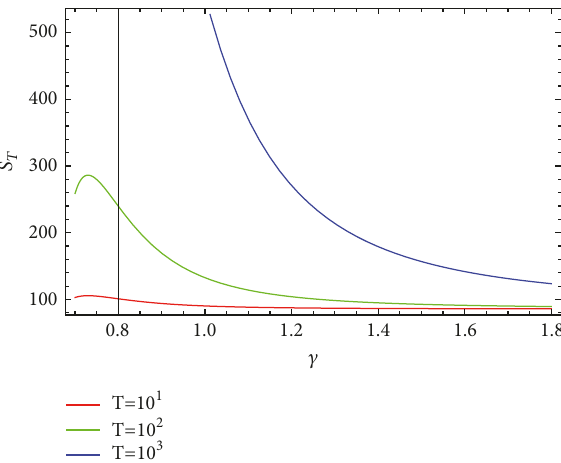
𝛾 for logarithmic corrected 𝑇 versus